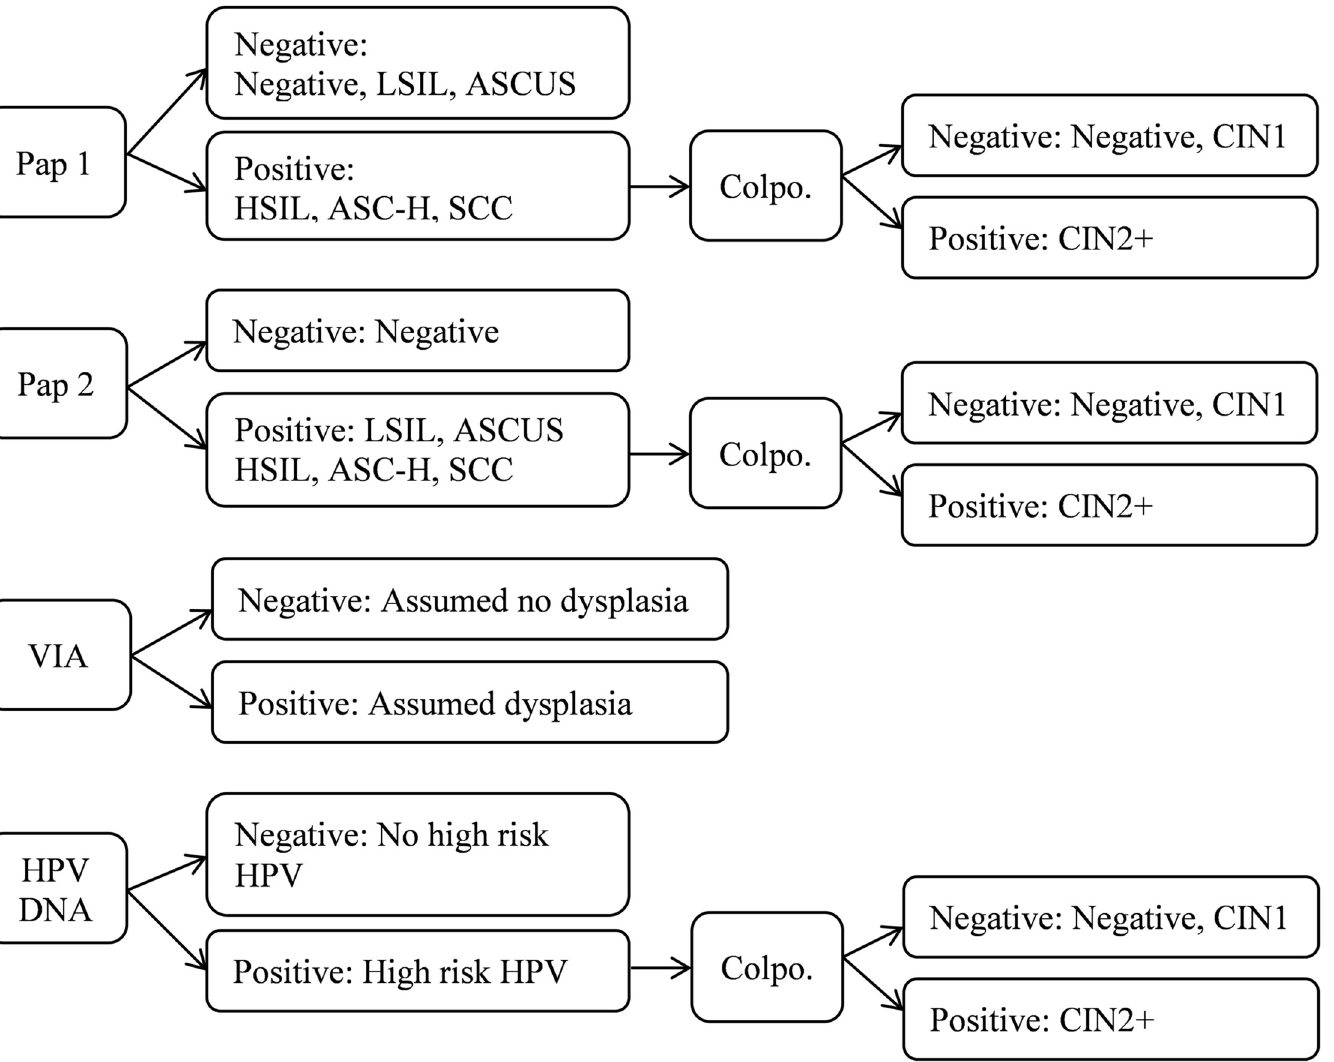
Fig 2. Strategies for cost-effectiveness analysis comparing cervical screening methods. Colpo. = colposcopic biopsy, LSIL = low grade squamous intraepithelial lesions, ASCUS = atypical squamous cells of undetermined significance, ASC-H = atypical squamous cells cannot rule out high grade lesion, HSIL = high grade squamous intraepithelial lesions, SCC = Squamous cell carcinoma